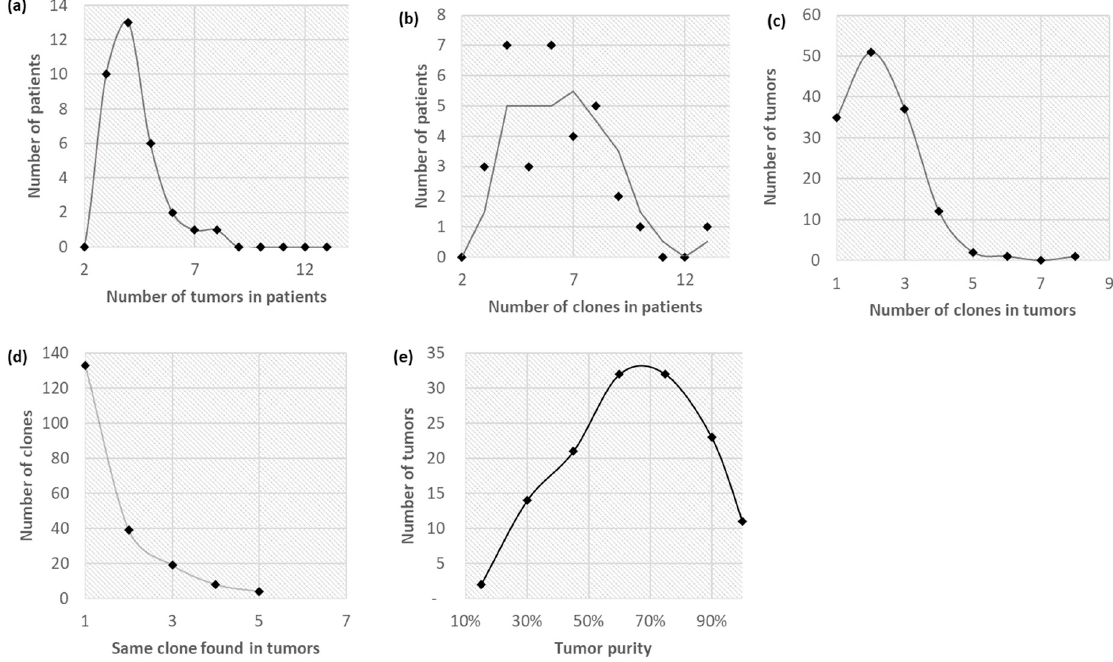
Figure 2. The distribution of clones in 139 tumors sampled from 33 patients from the Zhao cohort, deconvolved into 203 clones. ( a ) The distribution (smoothed line) of the number of distinct tumors in patients (mean: 4.2, median: 4). ( b ) The distribution (sliding-average line with a window of 2) of the number of distinct clones in patients (mean: 6.2, median: 6). ( c ) The distribution (smoothed line) of the number of clones in tumor samples (mean: 2.3, median: 2). ( d ) The distribution (log-transformed fit line) of the number of tumor samples in which each clone was found (mean: 1.6, median: 1). ( e ) The distribution (smoothed line) of tumor purities (estimated from the clonal composition of tumor samples; mean and median tumor purity were both 61%).